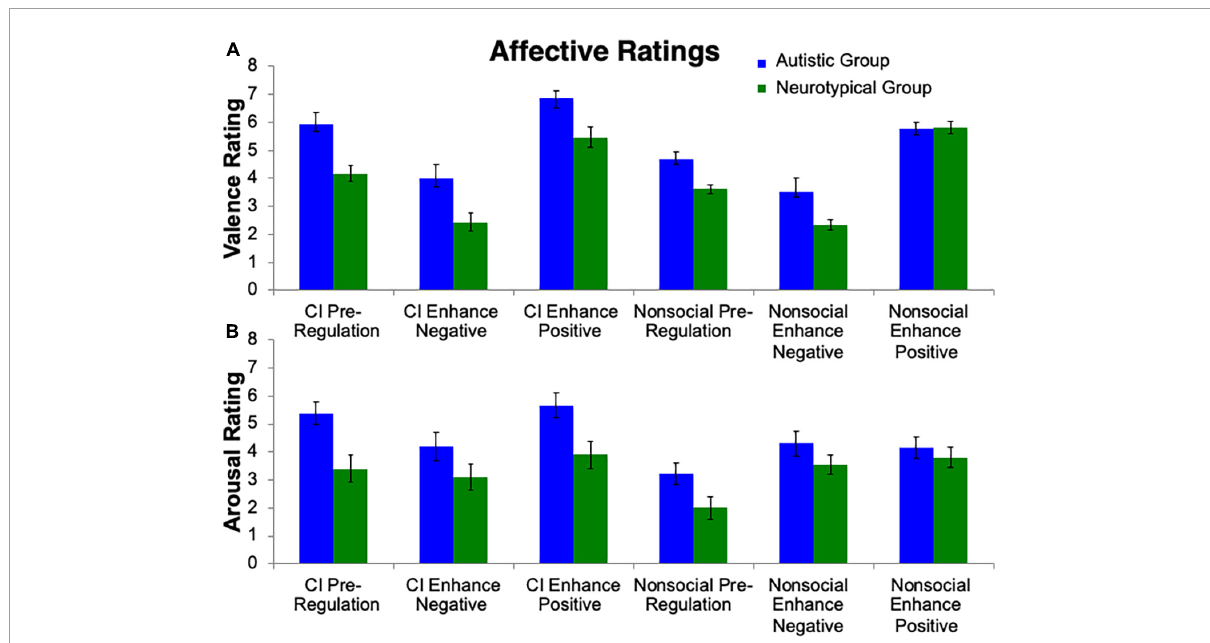
FIGURE2 Affective ratings. Valence and arousal ratings toward stimuli were collected. Group differences emerged for (A) valence ratings and (B) arousal ratings, i.e., that the autistic group reported greater valence and arousal than controls. Additionally, the autistic group reported greater valence and arousal toward CI images than nonsocial object images.